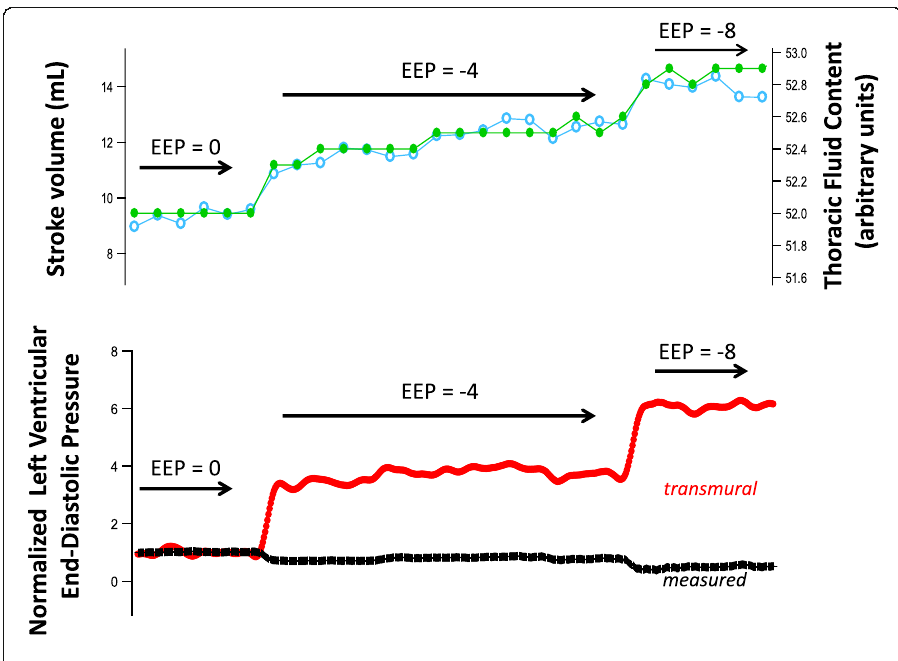
Fig. 6 Example of the dose-response of negative end-expiratory pressure on indices of left ventricular filling and ejection. The top panel displays changes in thoracic fluid content and stroke volume measured by bioreactance. The bottom panel shows the change in measured and transmural left-ventricular end diastolic pressure (EDP) as the expiratory pressure decreases. Ventricular pressures were normalized to their baseline values. This demonstrates that while measured EDP declined slightly, transmural EDP increased nearly sixfold